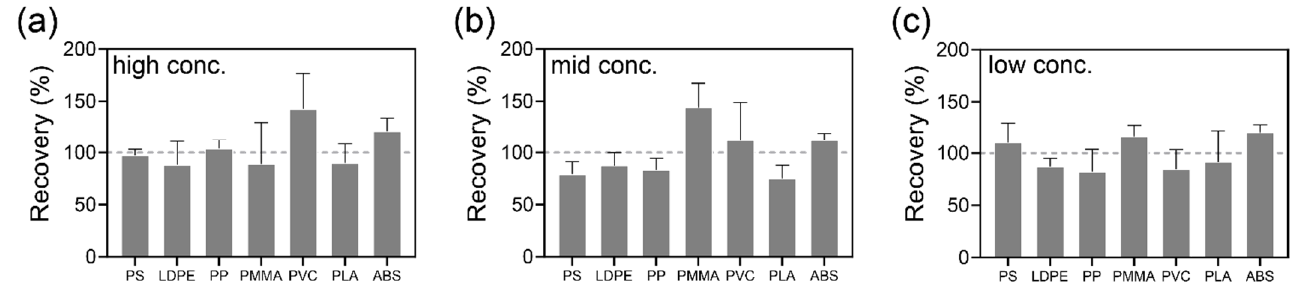
Figure 5. Recoveries of different types of stained MPs counted by flow cytometry. Each bar and error bar represent the mean recovery and relative standard deviations, respectively. Dashed lines represented 100% recovery. Three concentrations of MPs were tested, including ( a ) high concentration at 40,000 particles mL − 1 ; ( b ) medium concentration at 4000 particles mL − 1 and; ( c ) low concentration at 400 particles mL − 1 .